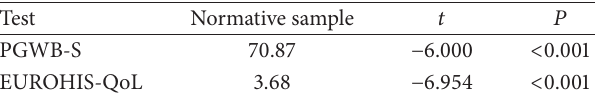
Table 3: Comparisons between PGWB-S and EUROHIS-QoL and respective normative scores.